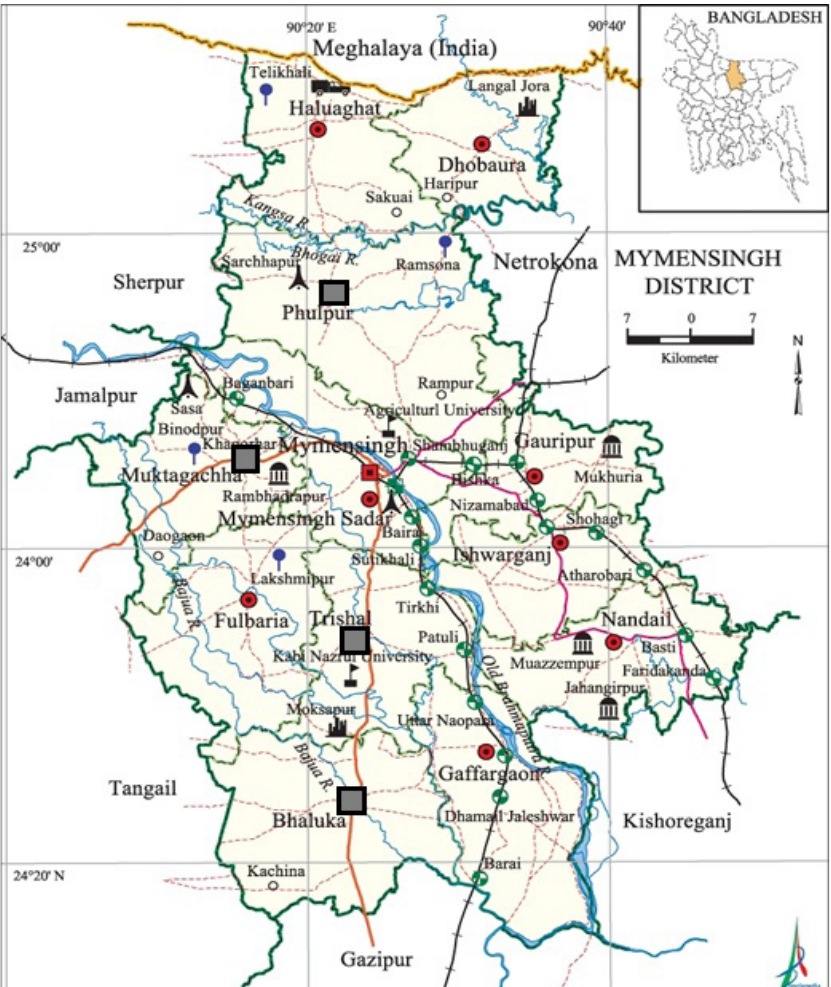
Fig. 1: Map of the study areas (rectangle marked area). Source: Mymensingh District (Islam